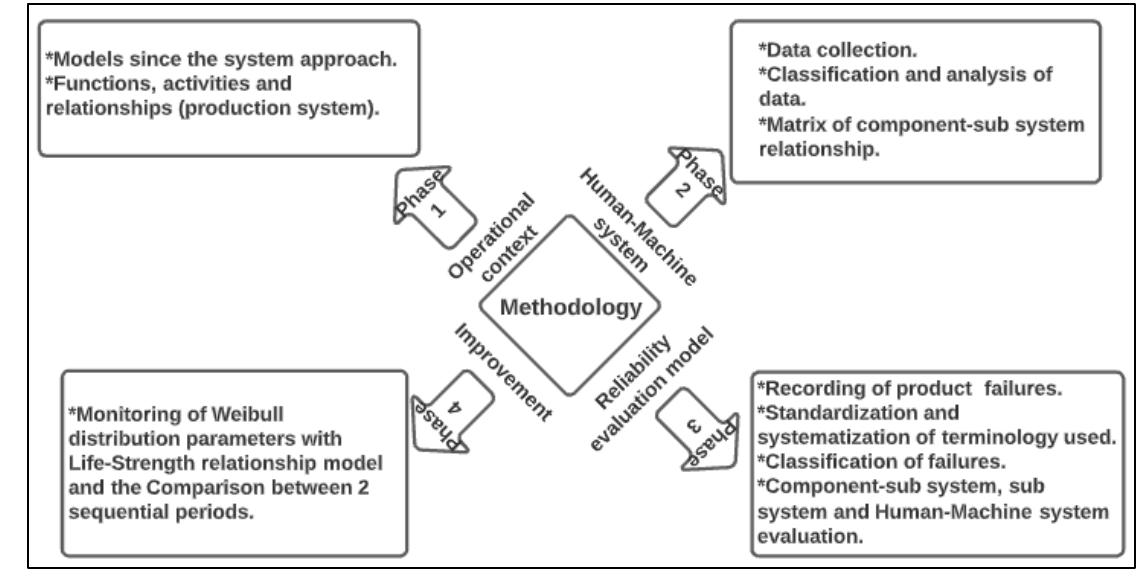
Figure 1. The four phases for the evaluation and improvement of the reliability of the human– machine system.